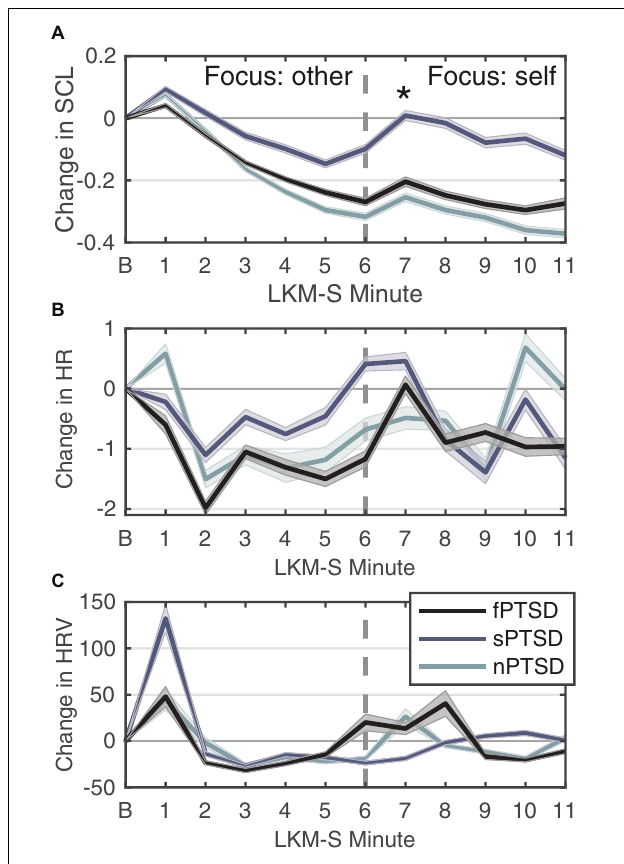
FIGURE 5 | Change in SCL (A) , HR (B) , and HRV (C) for each group in response to each minute of the LKM-S. Error bars are ± 1 SE. Panel (B) is the baseline minute, resting state, eyes closed. LKM-S minutes 1–5 focus on others, minutes 6–11 focus on self. In panel (A) sPTSD is significantly higher than nPTSD at minute 7 * p <